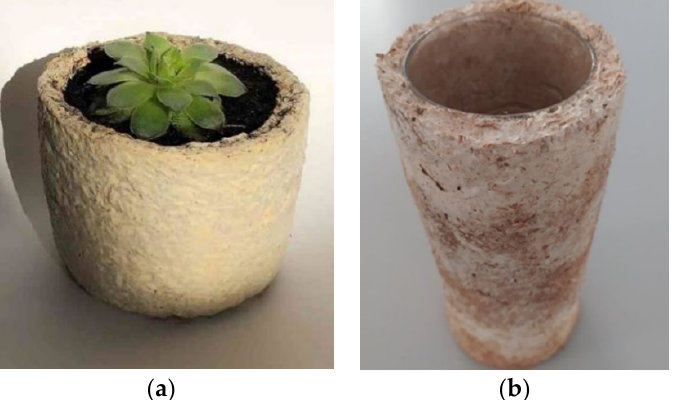
Figure 3. Mycelium-based biodegradable polymers: ( a ) flowerpot made from mycelium ( Open source photo ) [55]; ( b ) experimental sample of mycelium biopolymer ( Open source photo ) [56].